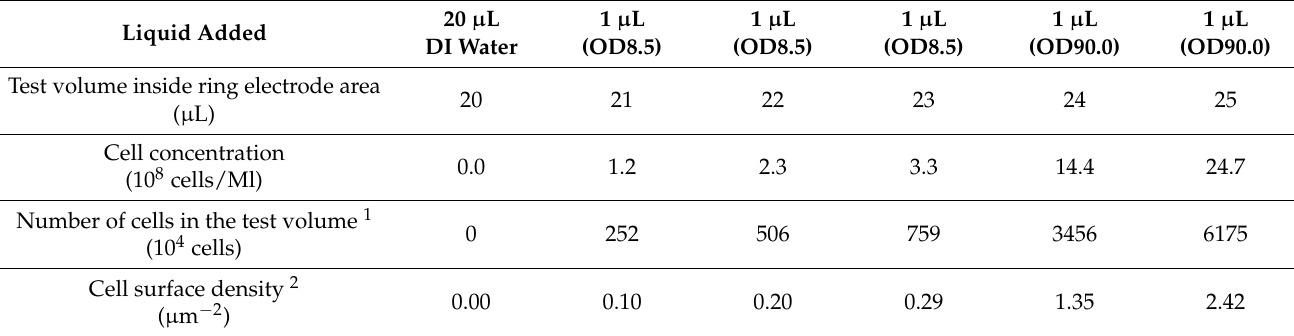
Figure 5. Nyquist plots for measured impedance of impedance chip BS5 (Table A2) without filling (No fill), with filling with DI water (20 µ L), and with addition of 1 µ L (OD8.5) (20 µ L + 1 µ L), 2 µ L (OD8.5) (20 µ L + 2 µ L), 3 µ L (OD8.5) (20 µ L + 3 µ L), 4 µ L (OD90.0) (20 µ L + 4 µ L), and 5 µ L (OD90.0) (20 µ L + 5 µ L) ( a ) DI water ( b ) Dead cells and ( c ) Live cells. The corresponding concentration of live and dead cells is given in Table 1. Table 2. Test volume inside ring electrode area in units of µ L, concentration of L. sphaericus JG-A12 cells inside ring electrode area of the impedance chips with 20 µ L DI water and with subsequently 1 µ L (OD8.5), 1 µ L (OD8.5), 1 µ L (OD8.5), 1 µ L (OD90.0) and 1 µ L (OD90.0) liquid added and corresponding number of cells in test volume and in units of 10 4 cells. OD1.0 corresponds to 3.0 × 10 8